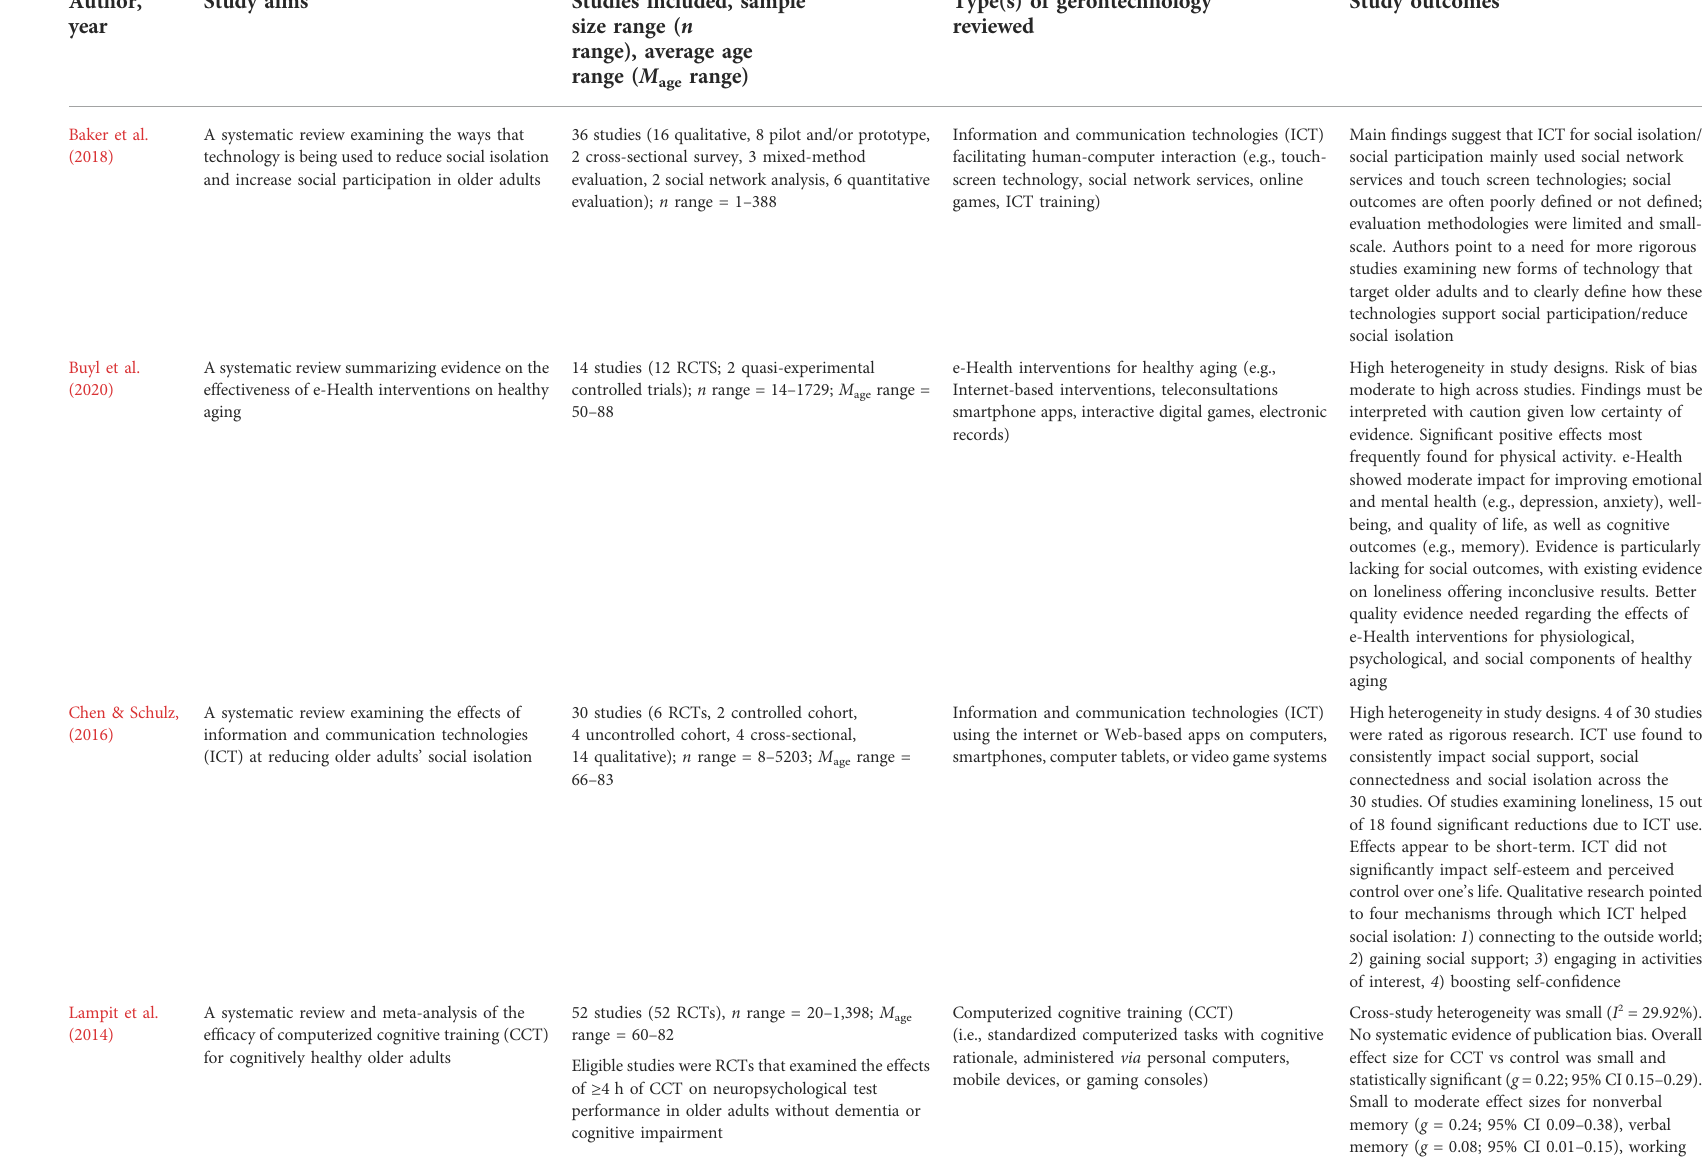
TABLE 1 Examples of recent reviews and meta-analyses evaluating gerontechnology aimed at improving mental health and well-being